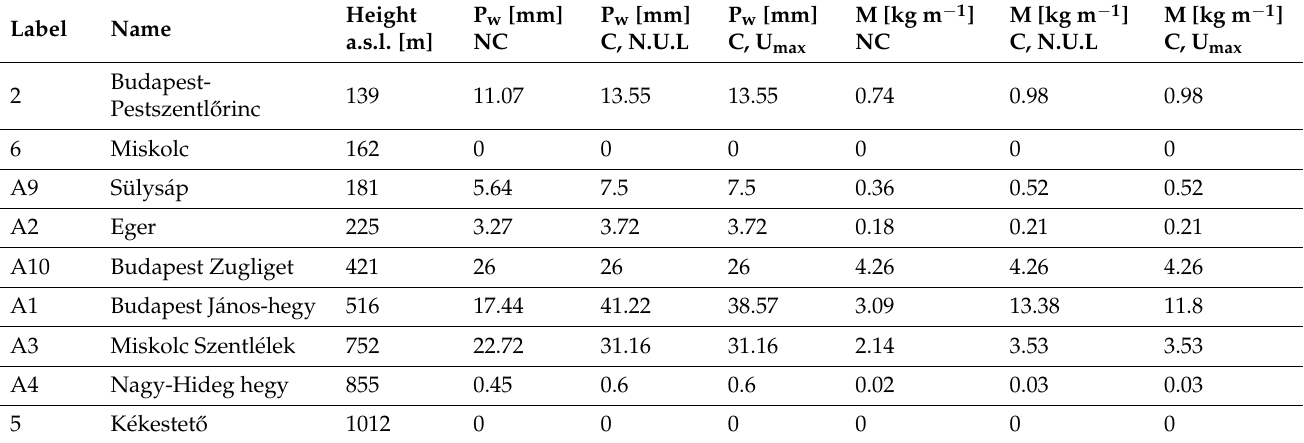
Table 11. Impact of the correction on wind on wet snow precipitation (P w [mm]) estimates and of the Resulting estimates of wet snow mass (M (kg · m − 1 )) are listed for the respective approaches (no correction on wind, correction applied, correction with wind speed limit). Values were rounded to two decimals. All calculations are valid for the wet snow event of 19–20 April 2017. (NC =